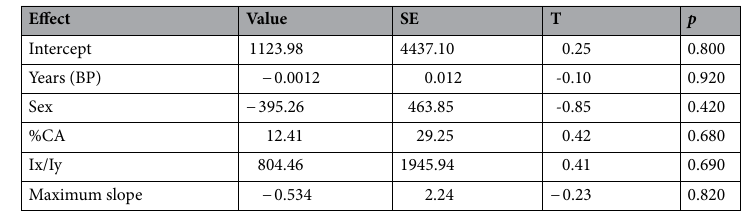
Table 2. Results of the linear mixed model (LMM) calculated for Neandertals a . SE standard error, T value of the t test, %CA percent of cortical area in a cross section, Ix/Iy ratio of Ix and Iy, R 2 = 0.0054. a Side of the body was used as a random effect with SD = 143.97. Bold indicates statistically significant p <